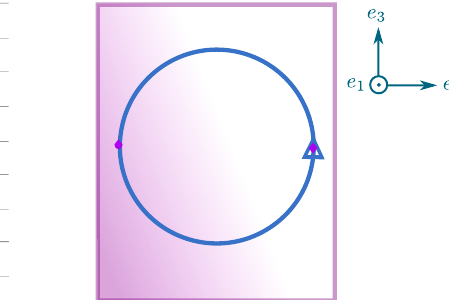
Figure 21 . An unknot K . Left: the projection of K to C . The projections of leaves of the WKB foliation are shown in light gray. Right: the projection of K to the leaf space of the foliation. We use purple dots to mark the two points on K where the projection of K to C is tangent to a leaf.